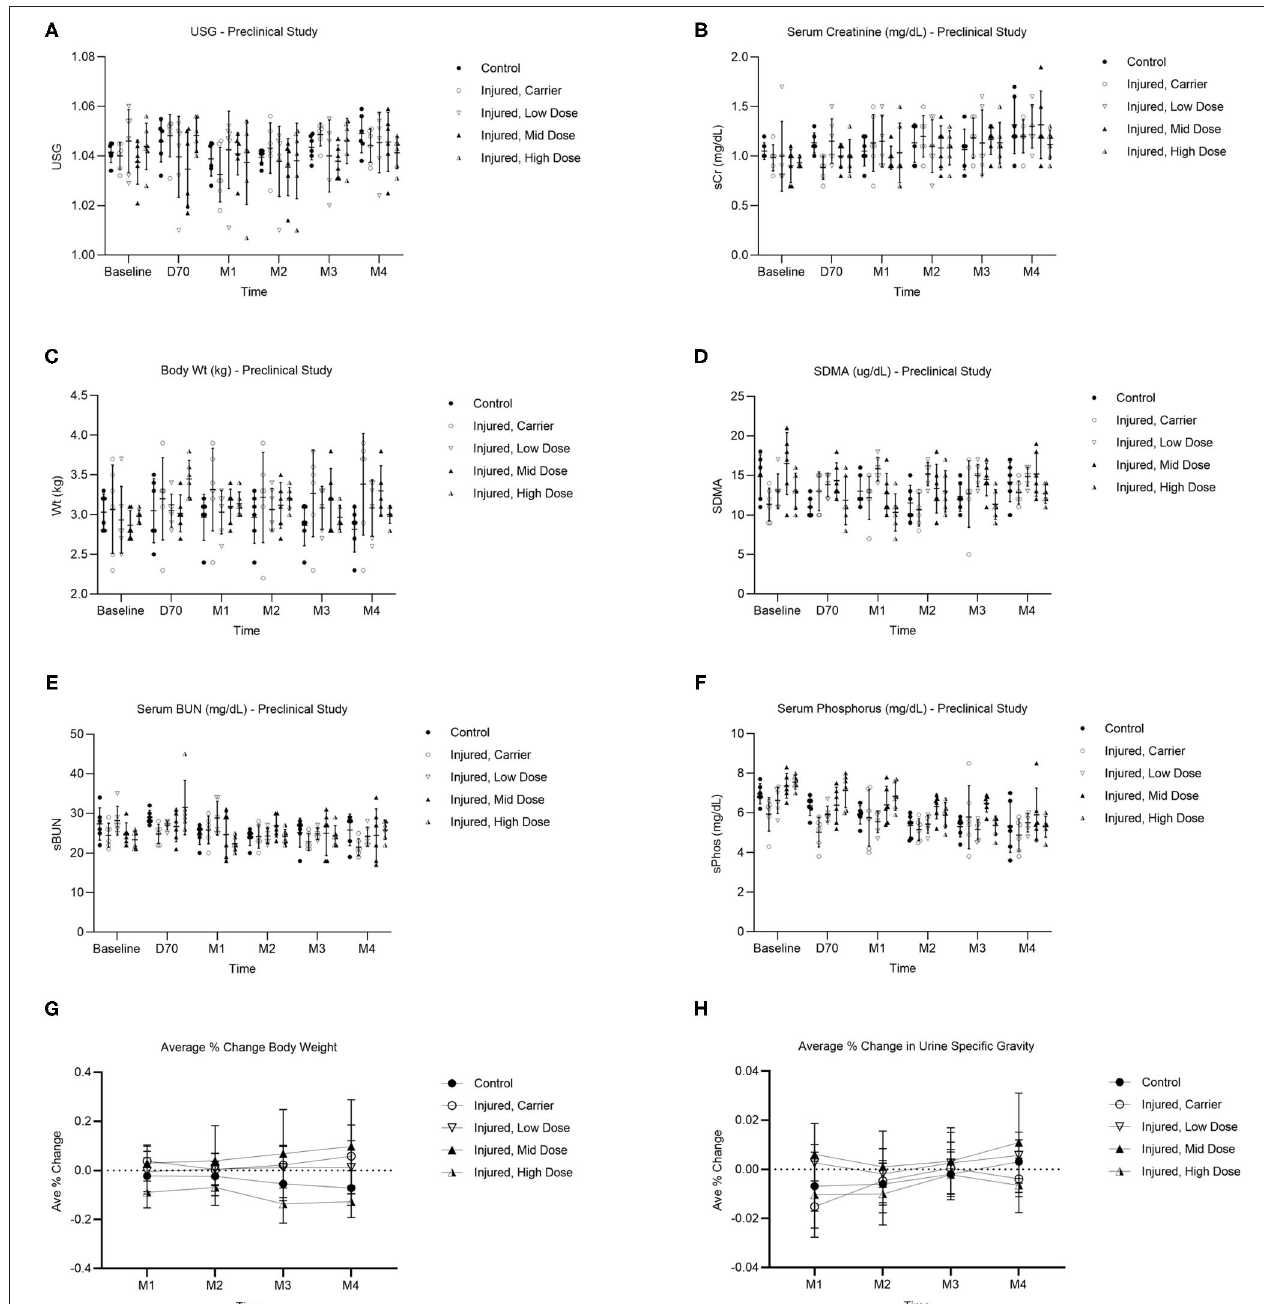
FIGURE 5 | Pre-clinical study clinical pathology results of renal function over time (Baseline, Day 70, Month 1, Month 2, Month 3, Month 4) for each group depicted as dot plot and mean ± SD showing: USG (A) , serum creatinine (B) , body weight (C) , SDMA (D) , serum BUN (E) , and serum phosphorus (F) . Average % change in body weight (kg) (G) and USG (H) over time (Month 1, Month 2, Month 3, Month 4) for each group when compared to day 70 post-injury (i.e., maximum injury), just prior to treatment injection. n = 6/group. Values are mean ±